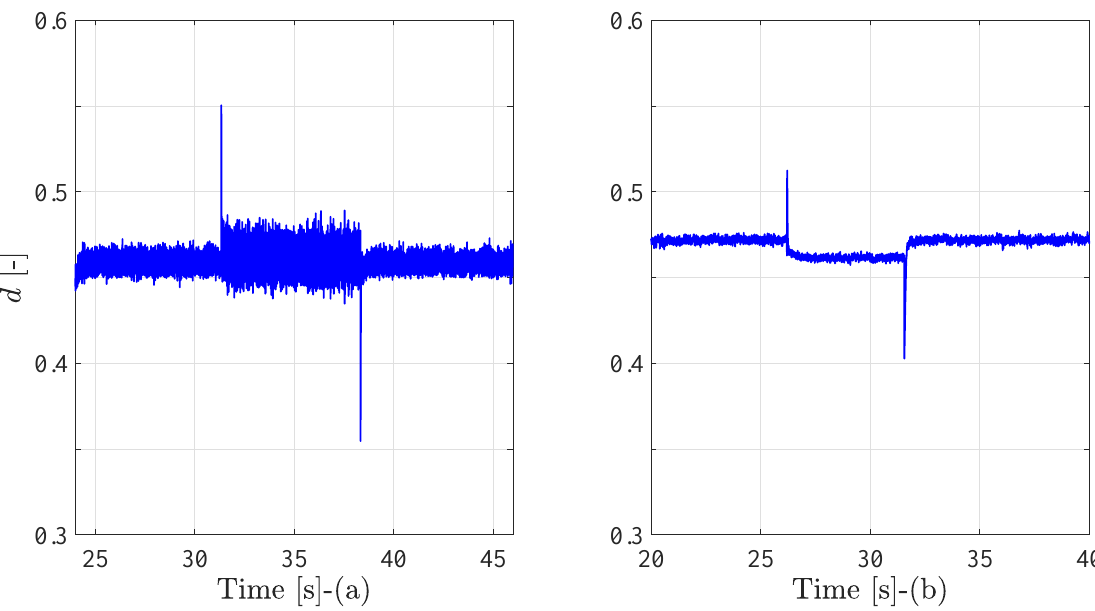
Figure 10. The duty cycle command of the boost converter: ( a ) Conventional P&O method with adaptive step-size and ( b ) proposed predictive method with two adaptive